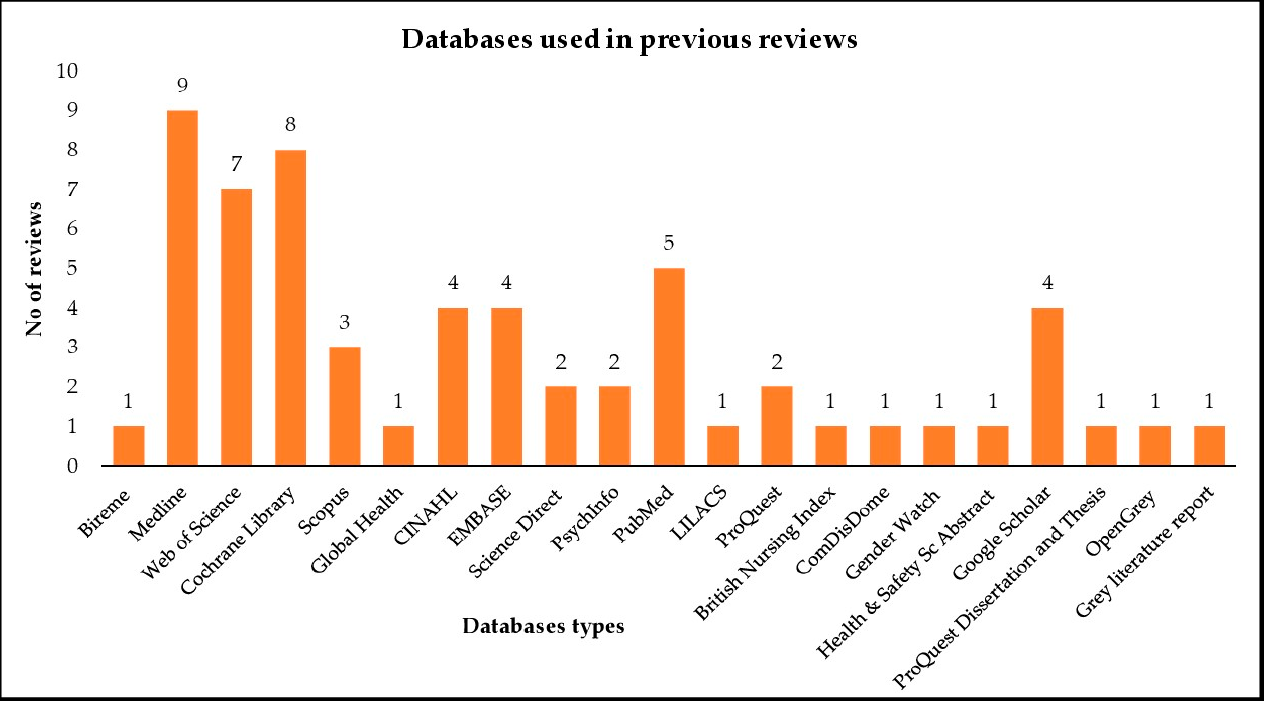
Figure 3. Number of databases used in previous systematic reviews.